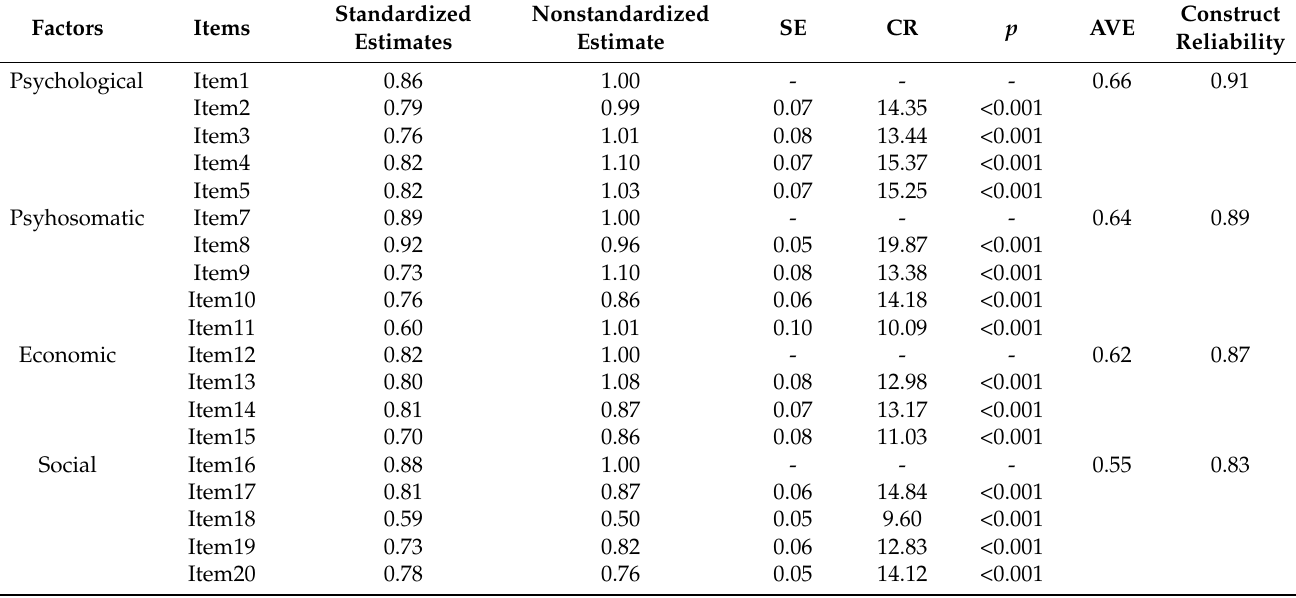
Table 3. Analysis of Convergent Validity of Items ( N = 226).